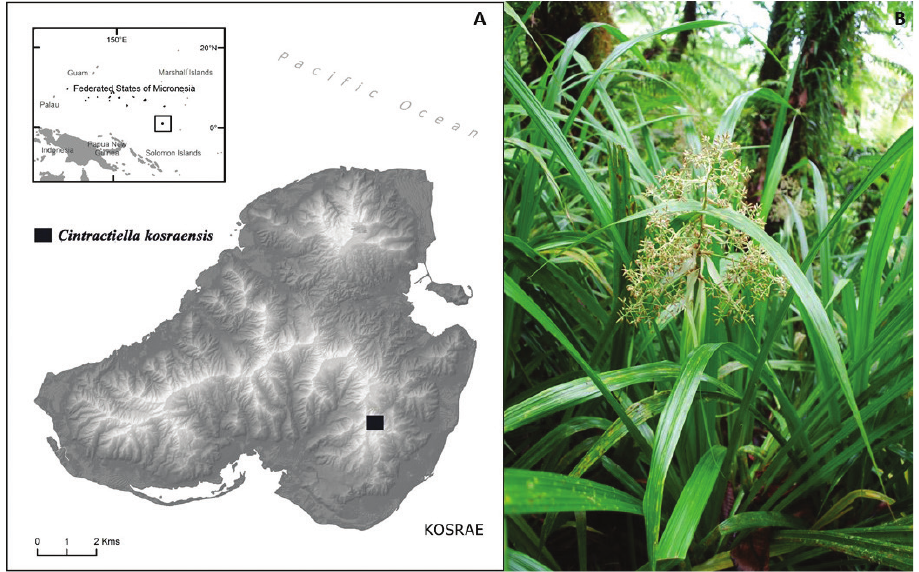
Figure 1. A Type location of Cintractiella kosraensis on the island of Kosrae, Federated States of Microne- sia B The indigenous host, Mapania pacifica , occurring along the summit ridge to Mt Oma.